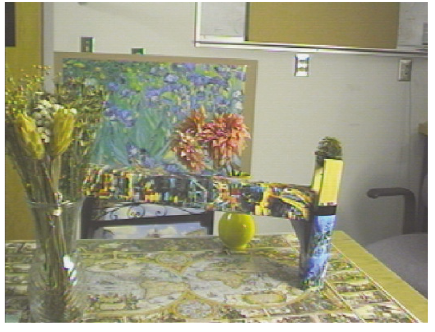
Figure 2: Reference image for the “o ffi ce” sequence.